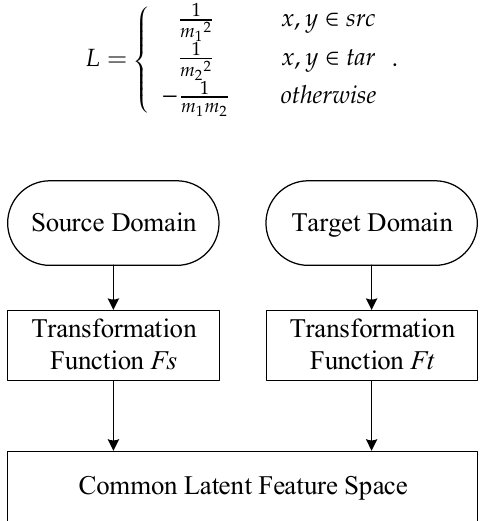
Figure 1. Schematic diagram of transfer component analysis (TCA).